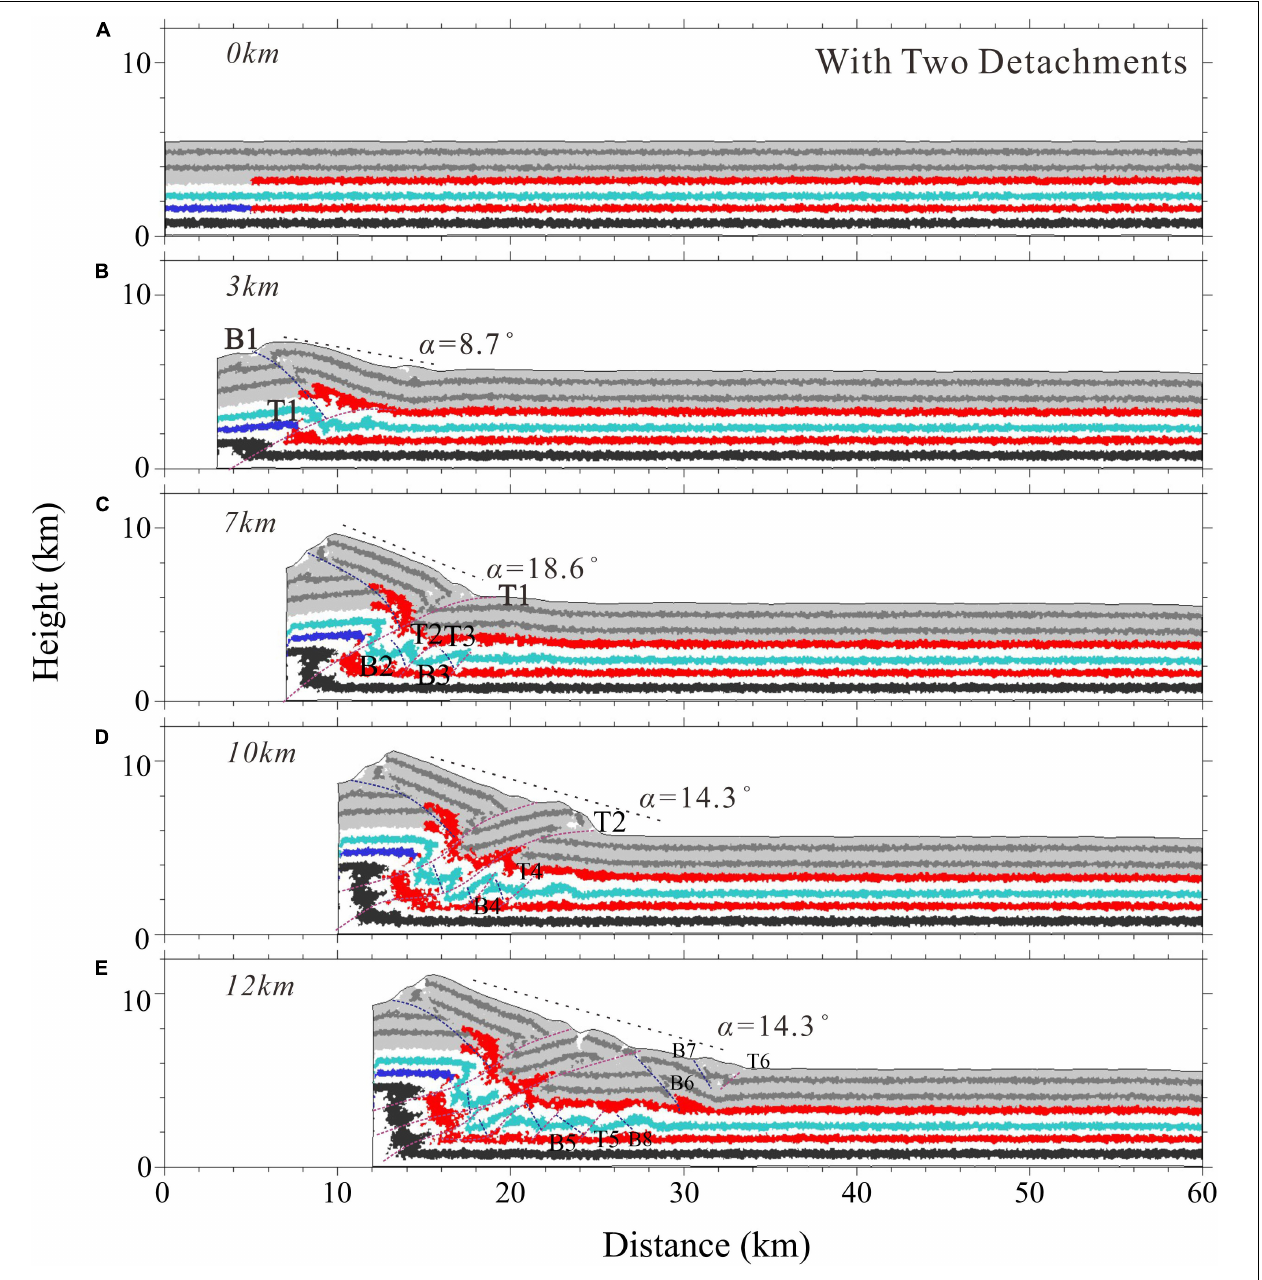
FIGURE 4 | Modeled progress with two detachments due to the left-wall displacement at shortening distances of (A) 0 km, (B) 3 km, (C) 7 km, (D) 10 km, and (E) 12 km. T1–T6 and B1–B8 denote fore-thrusts and back-thrusts, respectively, in the order of their formation; α represents the current slope